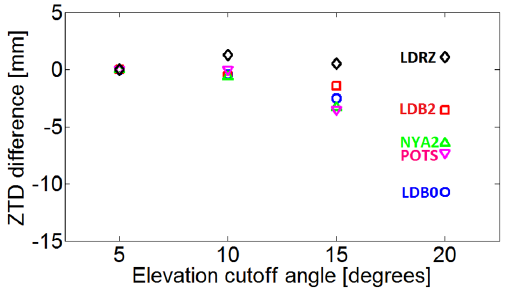
Figure 3. The impact of the elevation cutoff angle on the estimated ZTD for five GRUAN sites. The result obtained from the 5 ◦ eleva- tion cutoff solution is used as the reference, which however does not necessarily mean that it is the most accurate. Ideally, if all models are correct, the result shall not depend on the cutoff angle at all. Figure 4. Photographs of two GRUAN sites: (a) LDB2 and